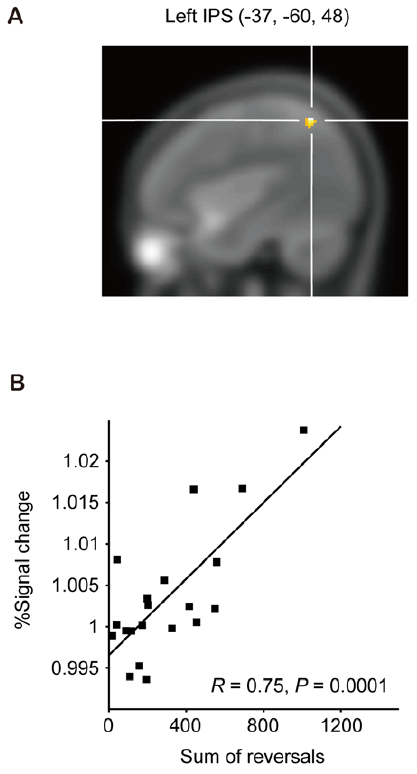
Figure 4. Regression analysis between the SR and the fMRI signal changes under the crossed L condition with partici- pants’ eyes closed. ( A ) The left intraparietal sulcus that showed a significant correlation between the fMRI signal changes (EC Crossed L - EC Uncrossed) and the degree of TOJ reversals due to arm crossing [( 2 37, 2 60, 48); P , 0.01, uncorrected, masked by the Crossed L– Uncrossed contrast at P =0.05]. ( B ) Panel highlighting the correlation between signal changes in the region of interest and the sum of the